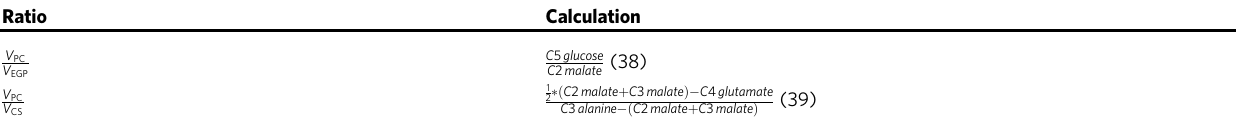
Table 3 Flux modeling ratios used in the ex vivo NMR method Ratio